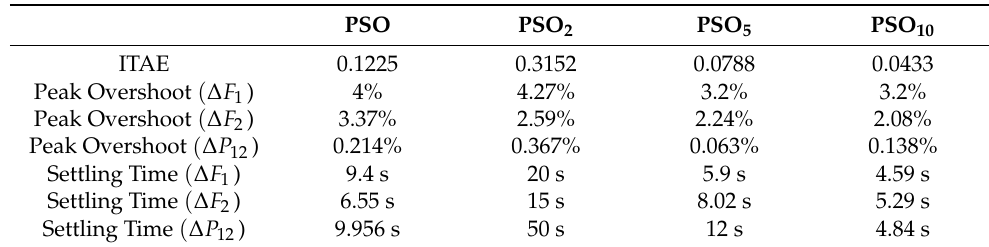
Table 6. Key performance parameters for the LFC of the test system, pertaining to case study-II, with PSO, PSO 2 , PSO 5 and PSO 10 .